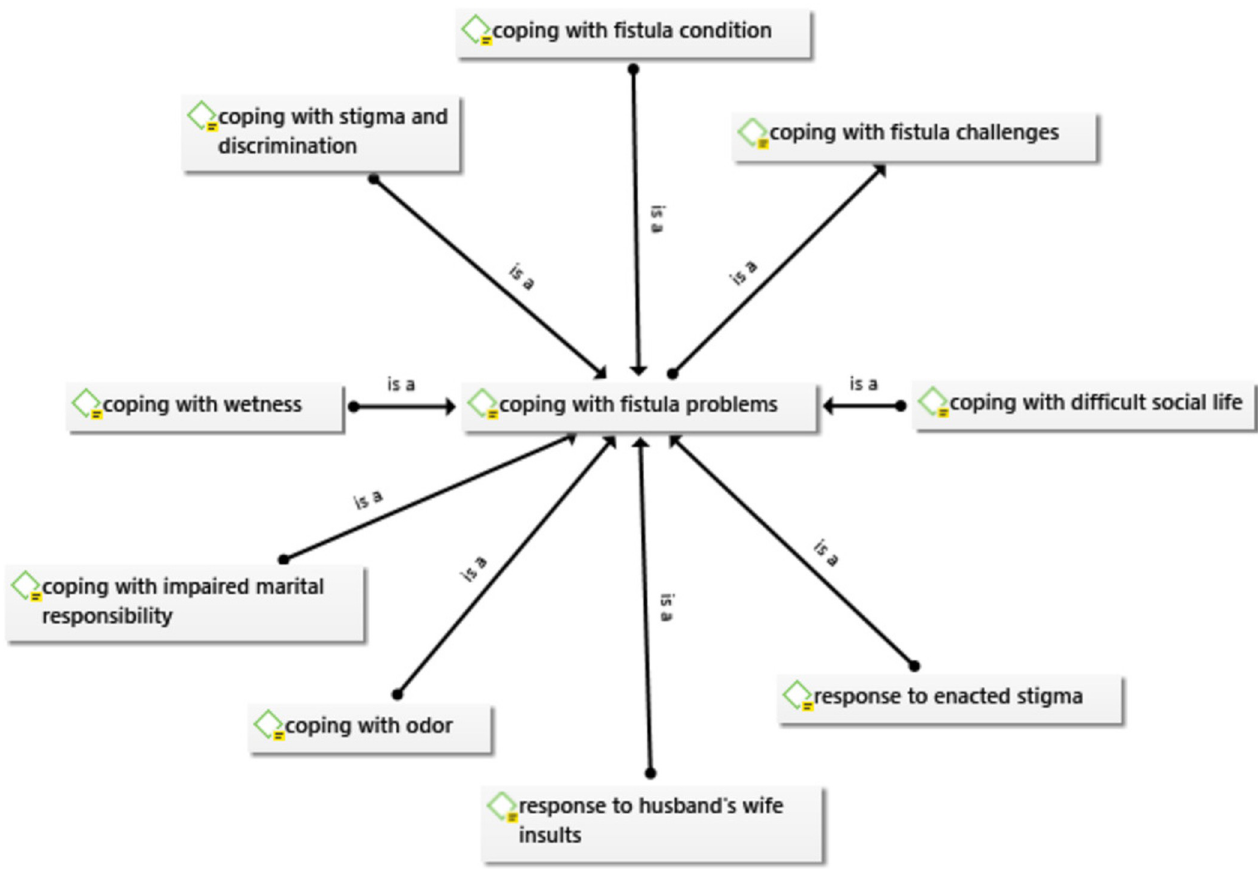
Fig 1. Coping mechanisms with obstetric fistula problems.